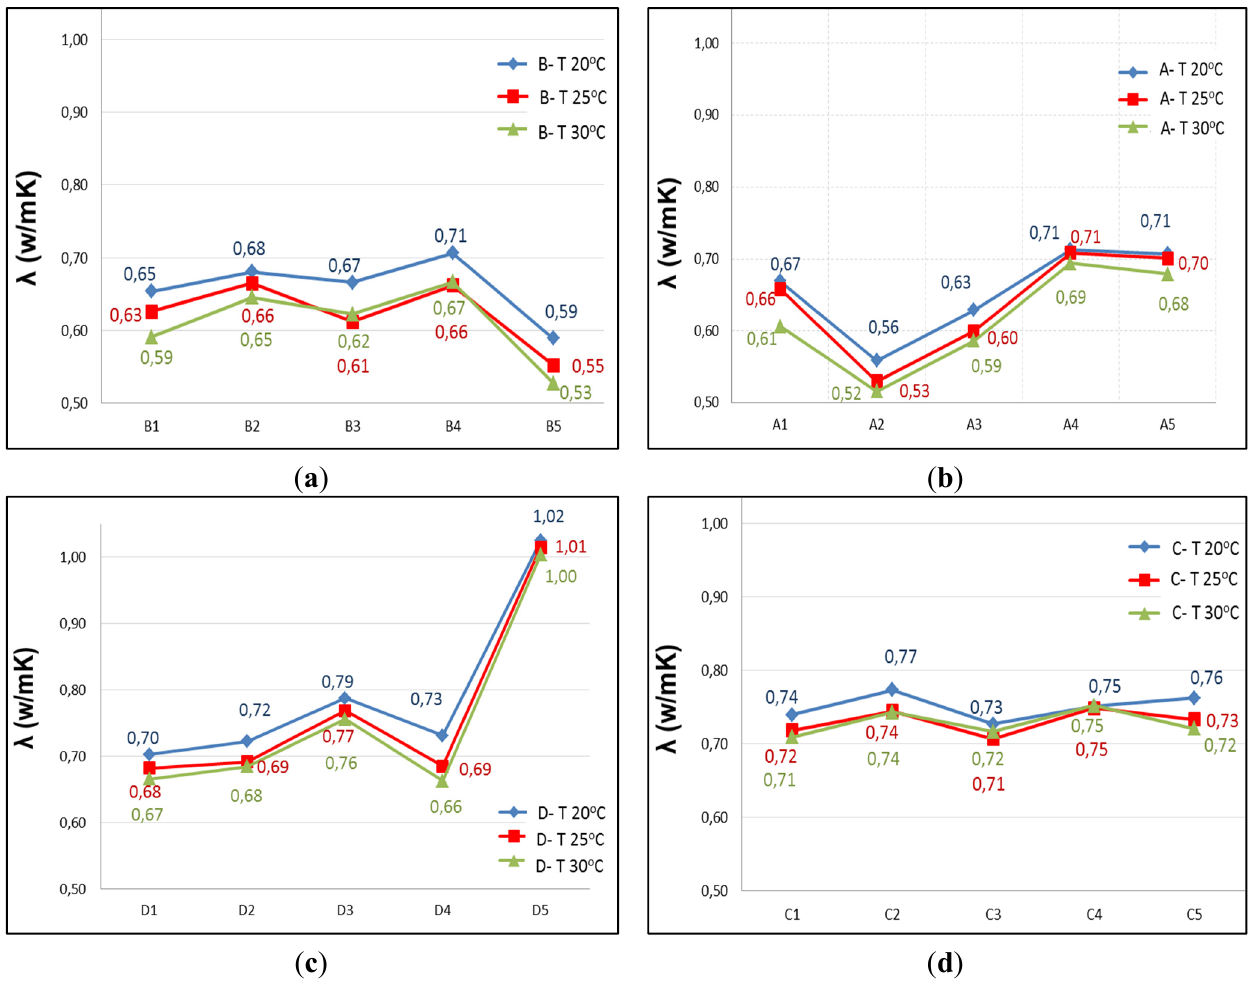
Figure 4. Conductivity at 20 °C, 25 °C and 30 °C: ( a ) Type A with 100% RA; ( b ) Type B with 50% RA; ( c ) Type C with 20% RA; and ( d ) Type D with 0%